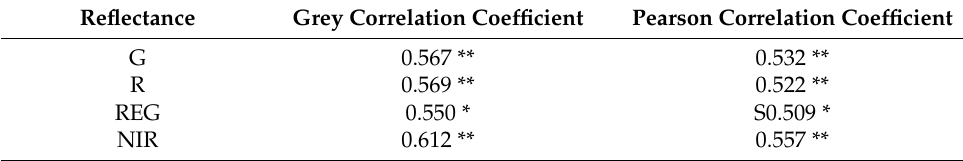
Table 4. Correlation analysis of sensitive reflectance with soil salinity. Reflectance Grey Correlation Coefficient